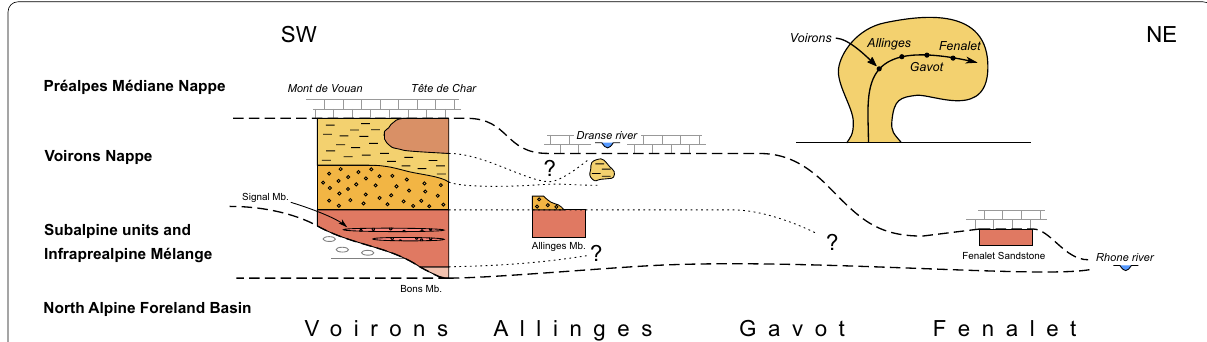
Fig. 9 Cross‑section showing the lateral/basinward variations within the Voirons Nappe. Note the decreasing thickness of the nappe reflecting the proximal–distal gradient of the eastward‑deflected fan. The lateral extensions of the formations are not well constrained due to the thick Quaternary cover. The fine‑grained facies and basinward evolution of the Vouan Conglomerate is not known. Inset shows the respective location of the major geographic localities within the